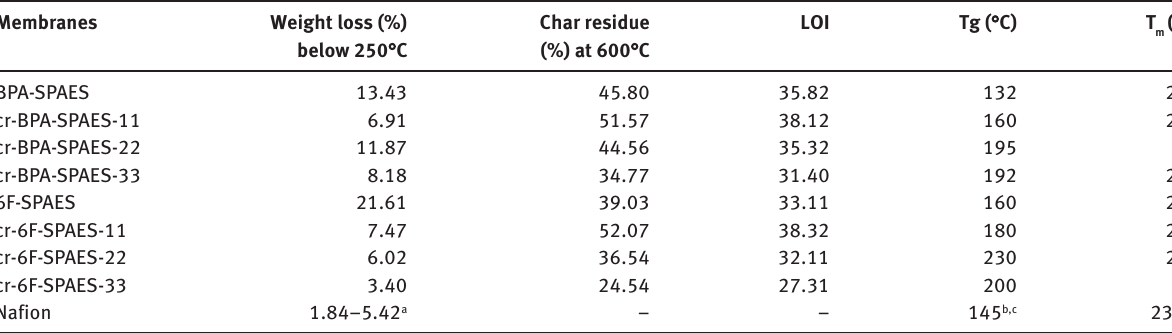
Table 3: Thermal behavior description by TGA and DSC.